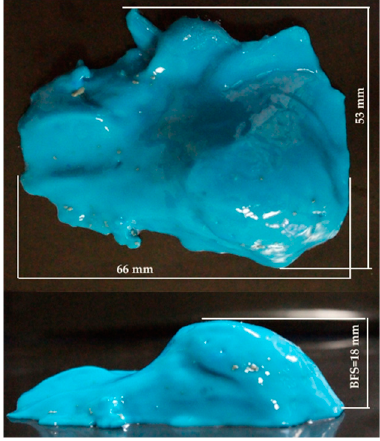
Figure 6. Cavity shape in the ballistic clay, obtained with a molding resin.